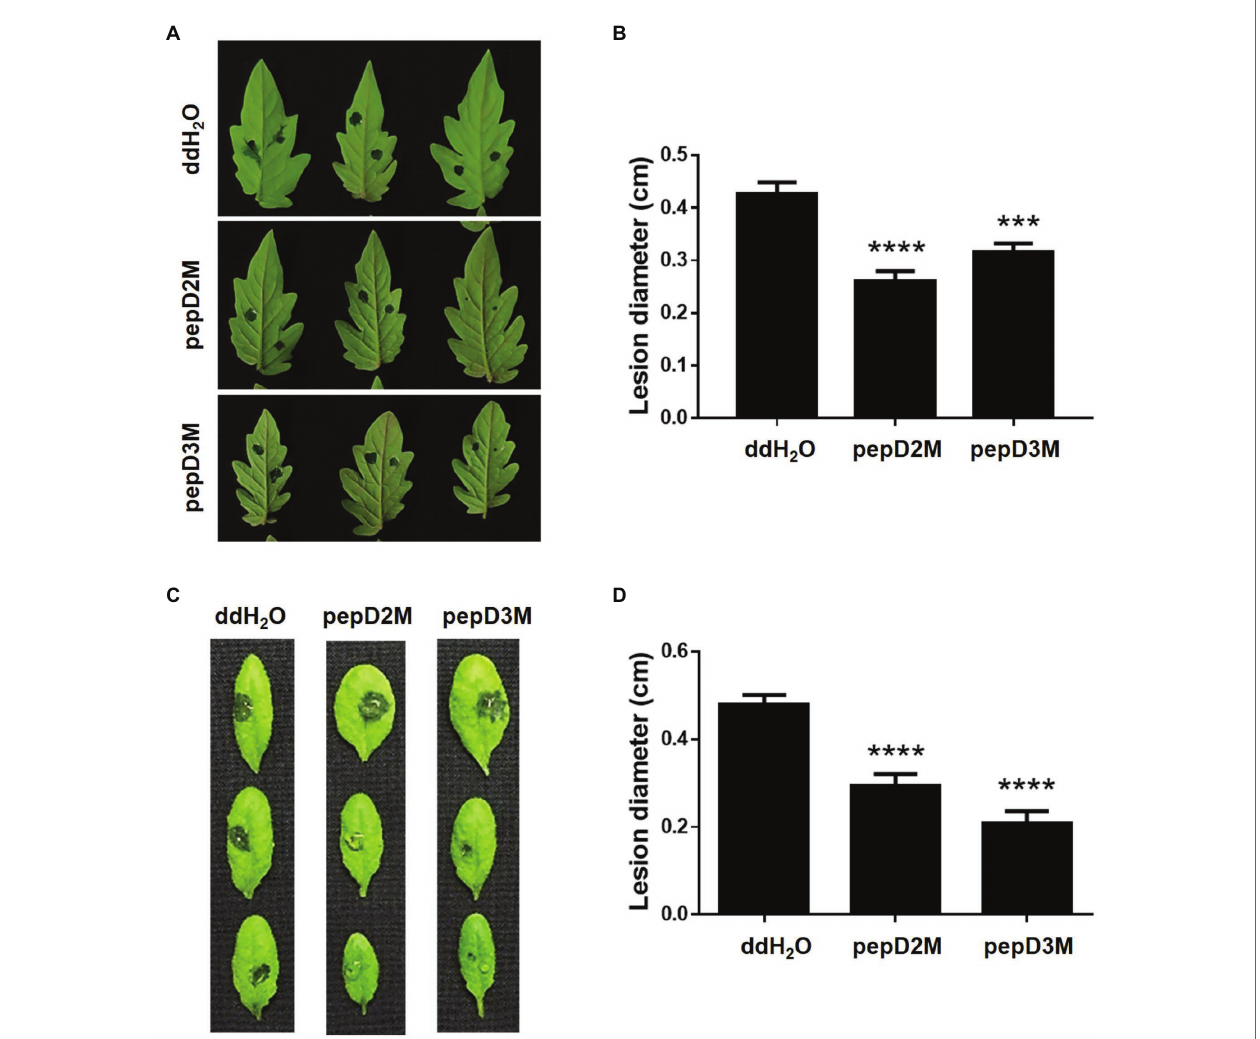
FIGURE 6 | Effects of pepD2M and pepD3M on the plant responses after the infection with Pectobacterium carotovorum subsp. carotovorum ( Pcc ). The Pcc cell suspension (10 6 CFU/ml in 10 mM MgSO 4 , 0.01% Silwet L-77) was mixed with the indicated peptide (64 μ g/ml) at a 3:1 ratio to produce a final peptide concentration of 16 μ g/ml. Crude peptides that were not purified via HPLC were used. Detached leaves of 4-week-old tomato L390 (A,B) plants and leaves of the intact Arabidopsis Col0 plants (C,D) were wounded with a 10 μ l micropipette tip and then droplet inoculated with 10 μ l of the Pcc -peptide mixture on the wounding sites. The disease symptoms were photographed 16–28 h post-inoculation (A,C) , after which the diameters of the lesions were measured (B,D) . The data are from a single experiment that was repeated at least three times with similar results. (B,D) The values are the average ± standard error (SE; n ≥ 30). Pair-wise comparisons of the water- and peptide-treated samples were made using the Student’s t -test (*** p < 0.001; **** p <